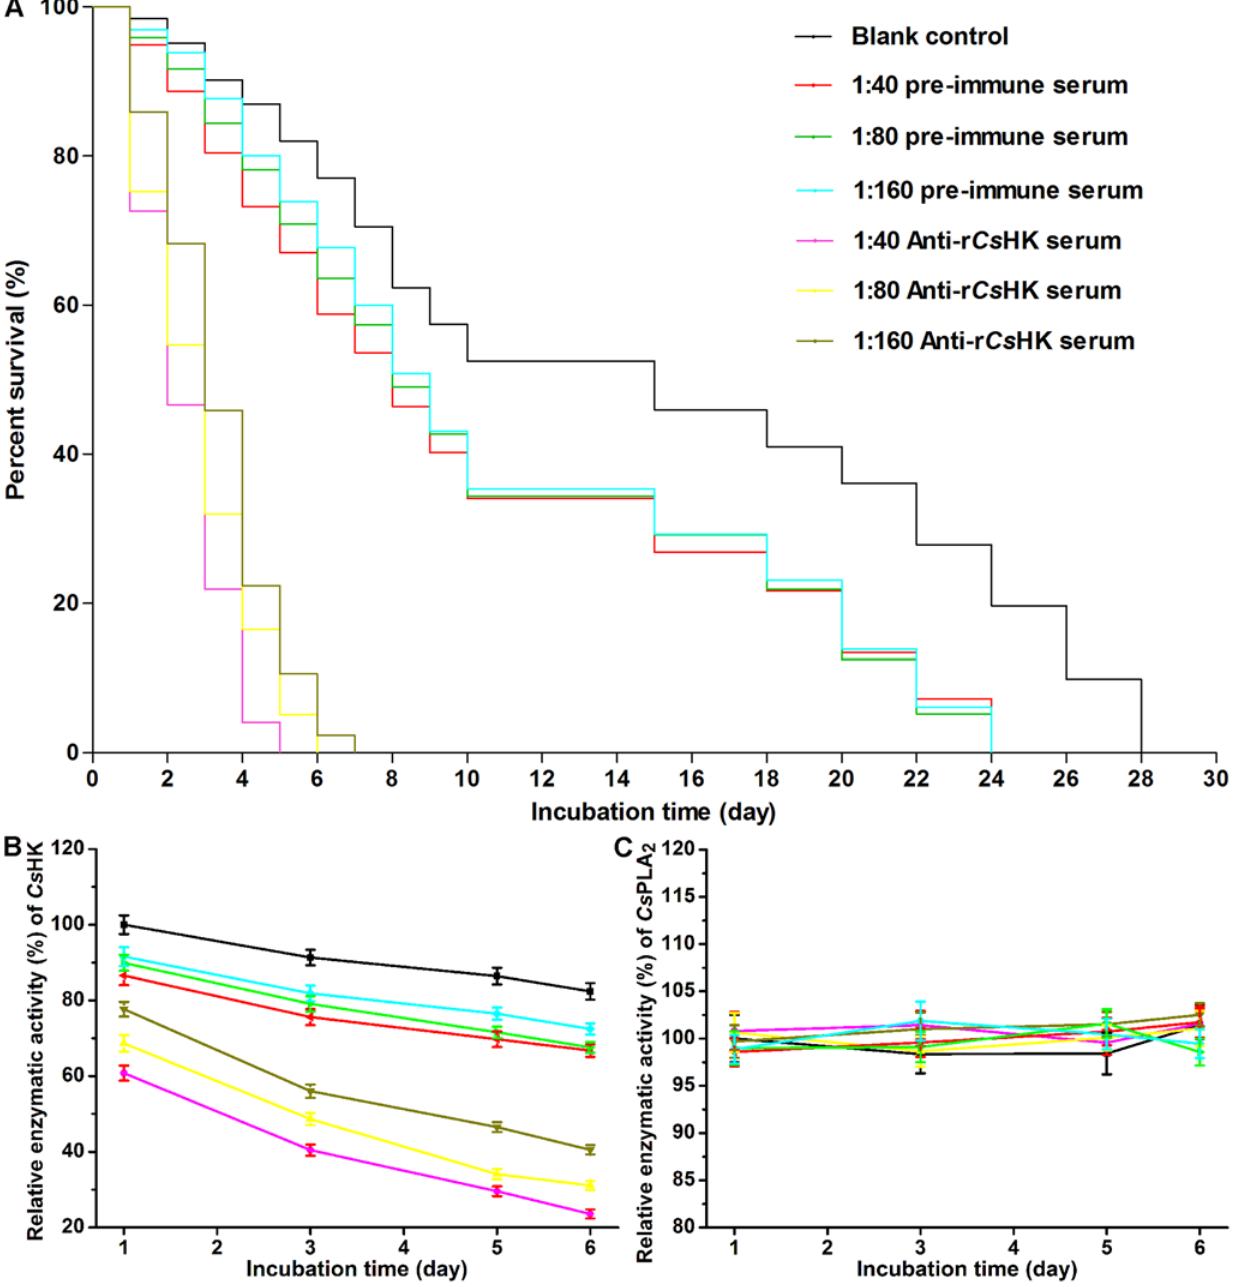
Fig 6. Rat anti-r Cs HK serum affects C . sinensis adult survival in vitro. (A) The median survival of C . sinensis adults in the blank control group, 1:40 pre- immune serum group, 1:80 pre-immune serum group, 1:160 pre-immune serum group, 1:40 anti-r Cs HK serum group, 1:80 anti-r Cs HK serum group, and 1:160 anti-r Cs HK serum group was 15, 8, 8, 9, 2, 3, and 3 days, respectively. There was no significant difference in survival rates among pre-immune serum groups at any dilution ( p > 0.05). Significant differences were observed in the survival rates among the other groups ( p < 0.05). (B) The enzymatic activity of Cs HK in homogenate of parasites collected from each group at 1, 3, 5, and 6 days of incubation. The enzymatic activity of Cs HK in adult worms incubated in medium with different dilutions of anti-r Cs HK serum declined significantly in a dose- and time-dependent manner. (C) As a control, there was no obvious change of the enzymatic activity of Cs PLA 2 in the